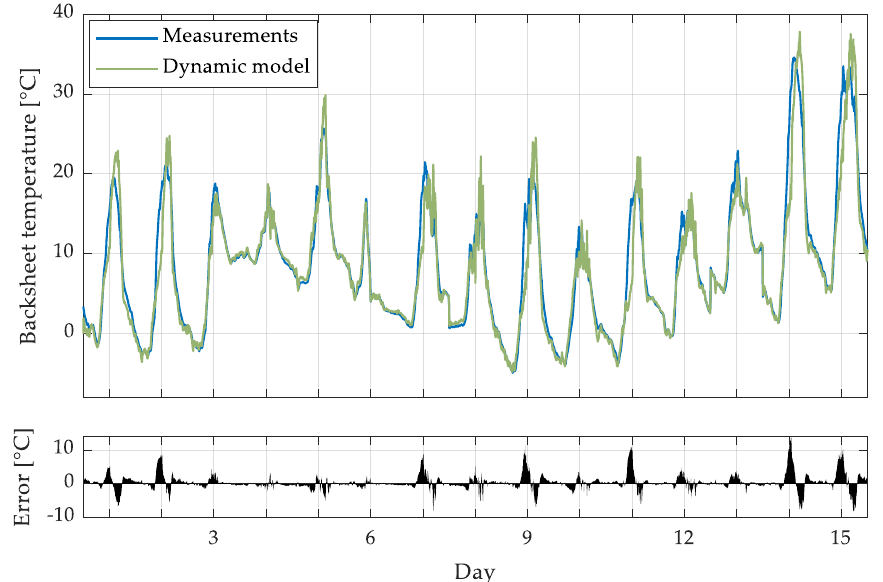
Figure 5. Validation of dynamic thermal model (Matlab/Simulink) with measurements (for 15 days in March 2021).